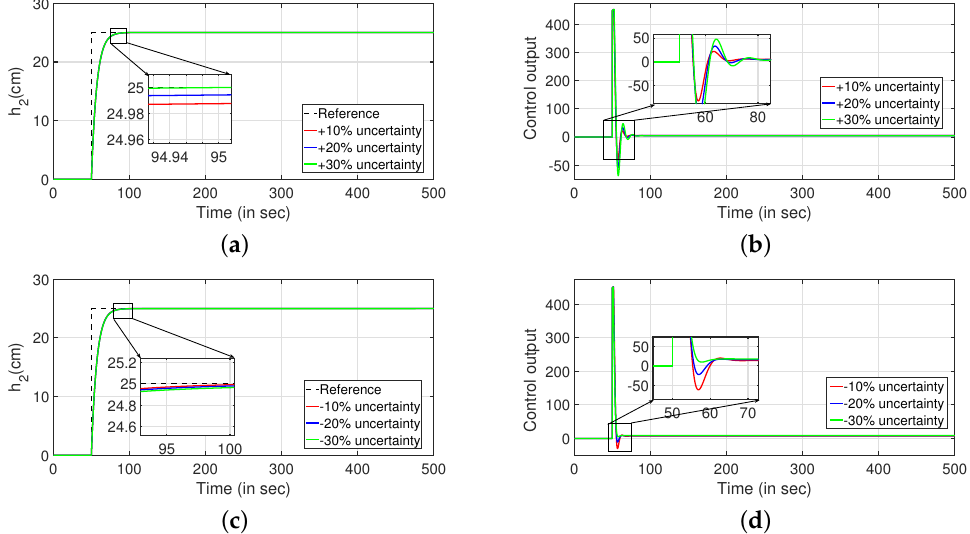
Figure 19. Reference tracking of Equation (44) for ± 10%, ± 20% and ± 30% uncertainties. ( a ) Level Variation in tank 2. ( b ) Control output. ( c ) Level Variation in tank 2. ( d ) Control output.